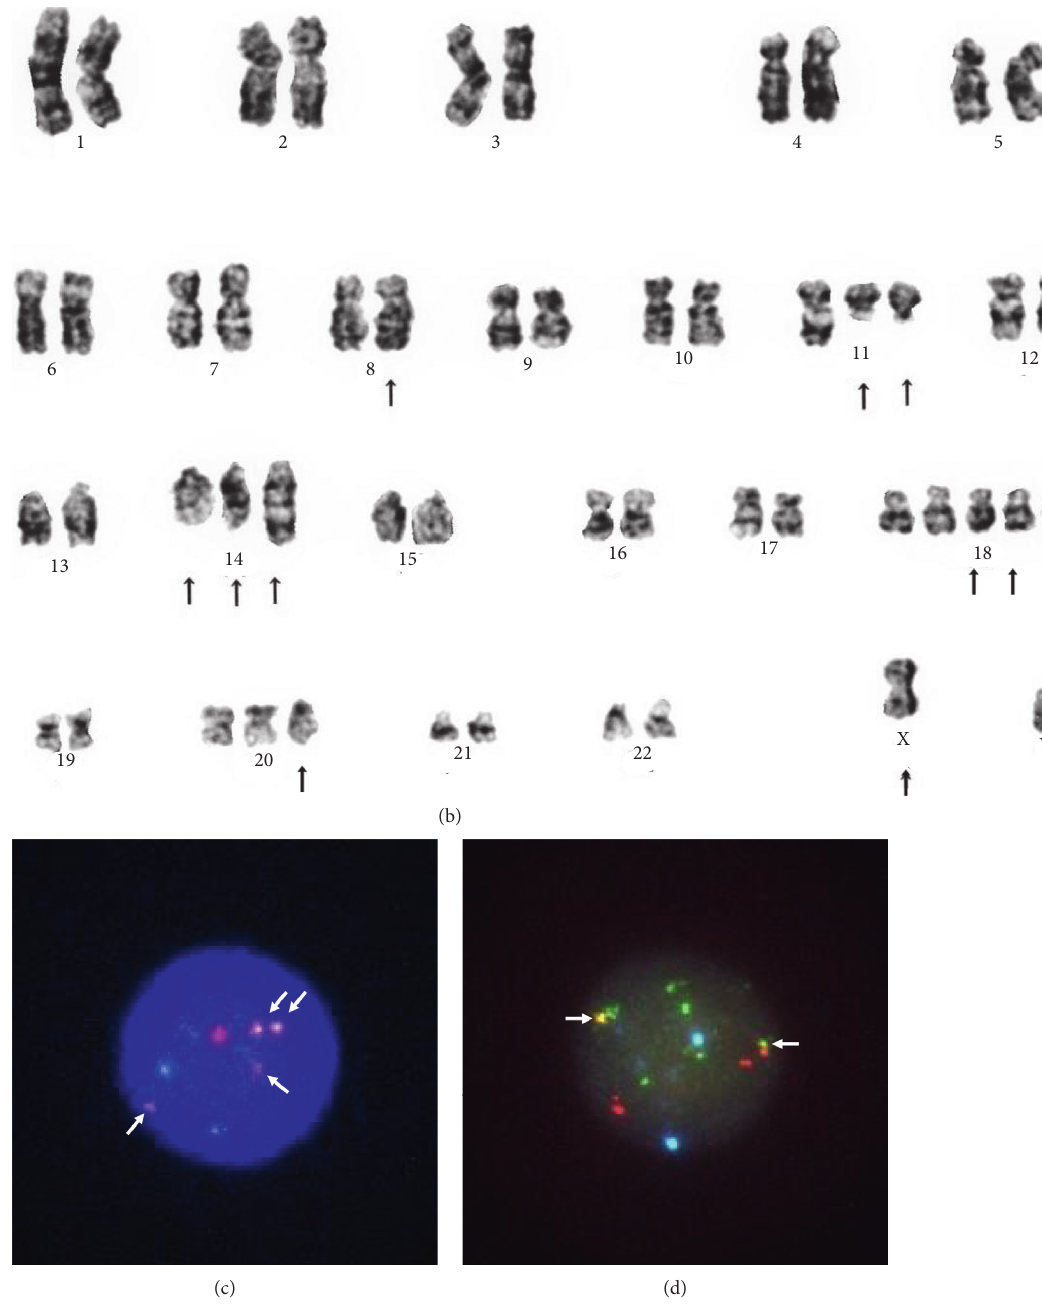
Figure 2: Karyotype of metaphase chromosomes and interphase fluorescence in situ hybridization (FISH) analysis obtained from the bone marrow. (a) The following complex karyotypes were observed at diagnosis: 47, Y, t (X; 8; 14) (q24; q24; q32), t (11; 14) (q13; q32), and +18. The arrows indicate the abnormal chromosomes. (b) Additional karyotype aberrations, including der (11)t (11; 14) and der (14)t (8; 14), were observed after IRd therapy. (c) FISH analysis was performed using a vysis LSI IGH/CCND1 dual color, dual fusion translocation probe. The orange signal represents CCND1, and the green signal represents IGH. Four fusion signals were observed. (d) FISH analysis was performed using a vysis LSI IGH/MYC/CEP 8 tri-color dual fusion probe. The orange signal represents MYC, the green signal represents IGH, and the aqua signal represents alpha satellite sequences on 8q11.1. Two fusion signals were